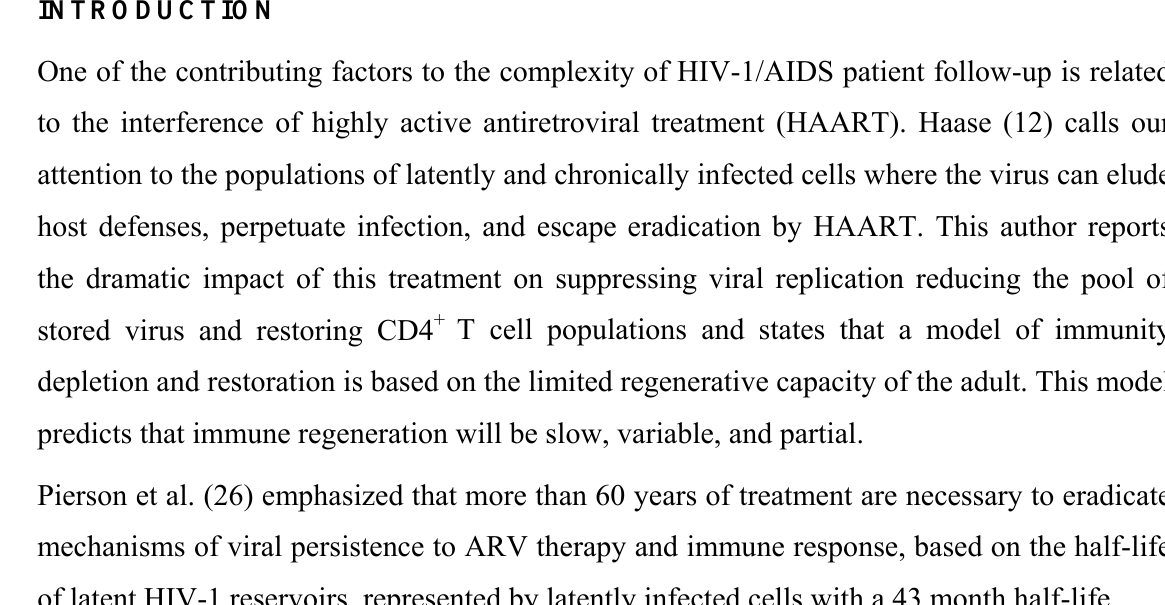
D. A. Meira et al. CORRELATION BETWEEN CYTOKINE SERUM LEVELS, NUMBER OF CD4 + T CELLS/mm³ AND VIRAL LOAD IN HIV-1 INFECTED INDIVIDUALS WITH OR WITHOUT ANTIRETROVIRAL THERAPY.